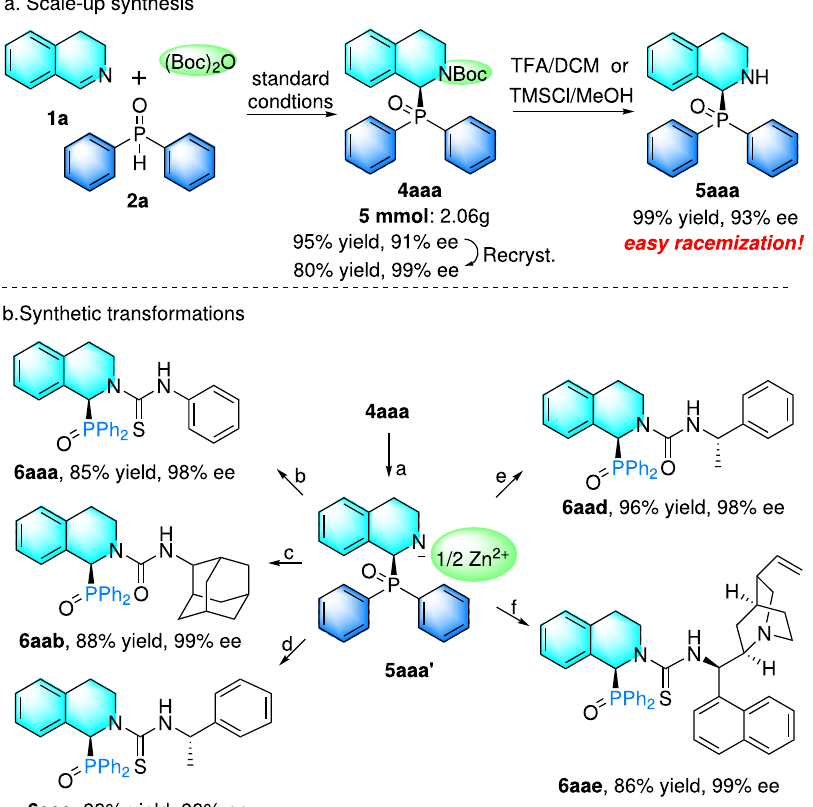
Fig. 4 Scale-up synthesis and synthetic transformations. a Scale-up synthesis, [a] Reaction conditions: 4aa (1 mmol), ZnBr 2 (1.2 mmol) in DCM (10 mL) at room temperature for 12 h, see Supplementary Notes. No further post-processing required; b Synthetic transformations, b-f Related iso(thio)cyanate compounds (1.2 mmol) were added, and the mixture was stirred at room temperature for 24 h. Isolated yields were given here and ee value was determined by